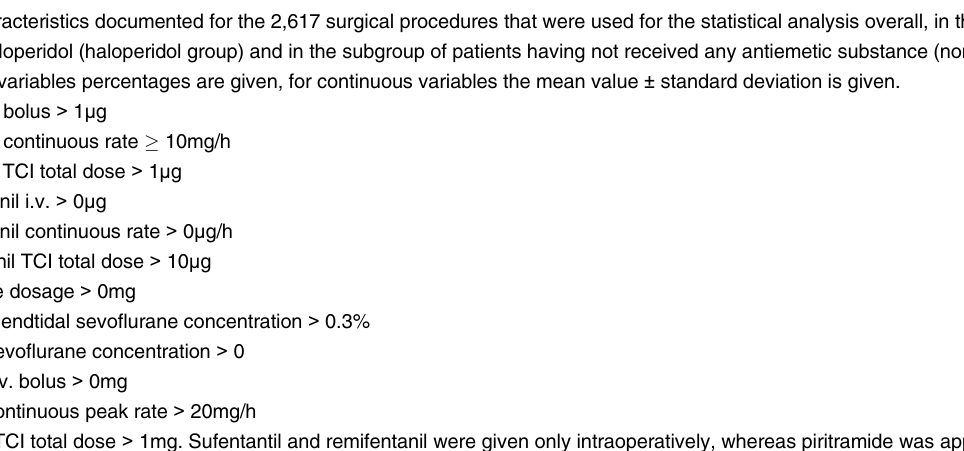
(Fig 3). The effects were non-linear for the duration of anesthesia, total intravenous sufentanil, remifentanil and piritramide application as well as for the maximum continuous rate of propofol. There is a significant effect for gender indicating that female patients have an approx. 3-fold higher risk for PONV than male patients with similar characteristics (p < 0.0001). No associa- tion was observed between age or BMI and the risk for PONV. A slightly higher but non-signif- icant risk can also be seen for non-smokers compared to smokers (OR = 1/0.78 = 1.28, p = 0.20). Patients with positive history of PONV have a higher risk for PONV (OR = 1.59, p = 0.17) compared to patients who have never experienced PONV before or for whom no information regarding PONV history was available, though also this association is not statisti- cally significant. The risk for PONV is reduced with increasing ASA status (p = 0.001). Patients with ASA 2 have a risk that is significantly lower at factor 0.56 (p = 0.008) and for patients